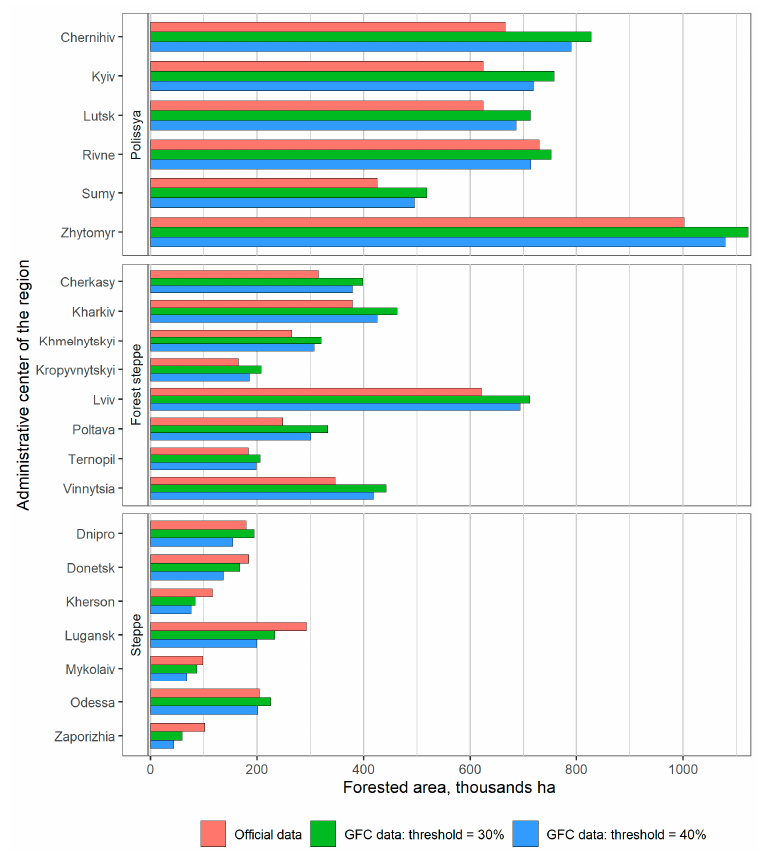
Figure 5. Regional estimates of forested area applying 30% and 40% thresholds for classification of GFC datasets.